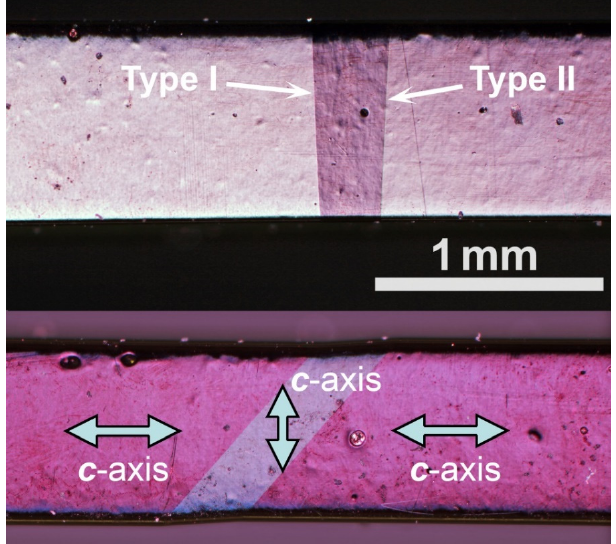
Figure 2. Two polarized light optical images of adjacent lateral surfaces of one of the studied samples with Structure 1 (Figure 1a). The sample consists of three martensitic variants separated by two a/c twin boundaries, Type I and Type II. The orientations of the c -axes, perpendicular in the two adjacent variants, are indicated by arrows.